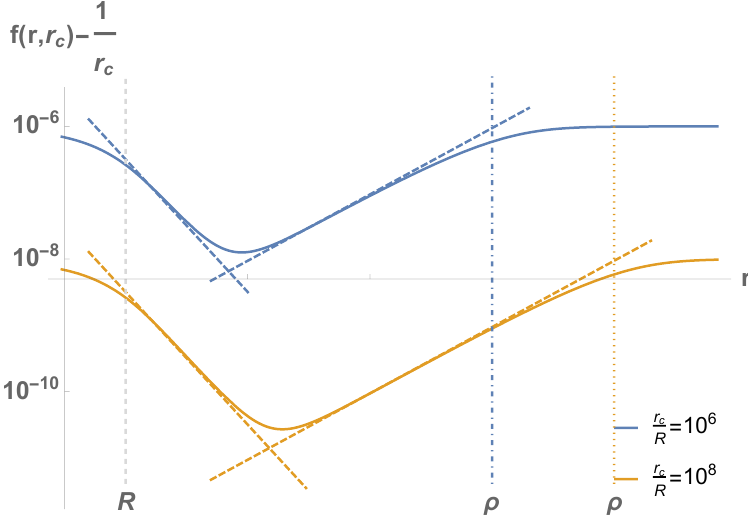
Figure 7. This log-log plot shows the numerical value of f (cid:0) 1 of R ) for two di(cid:11)erent values of r c =R as solid curves. The blue curve is plotted for r c =R = 10 6 and the orange one for r c =R = 10 8 . The dashed curves are the functions 1 for r ! (cid:26) , in two di(cid:11)erent colors depending on the value of r c =R . We see that the corrections given in (3.17) are good approximations for the numerical result, with 1 p 2 2 r dominating for larger r in the regime (II). The vertical lines show the scales, which separate 3 (cid:26) 3 the regimes. We see that for larger r c =R the approximation gets better.